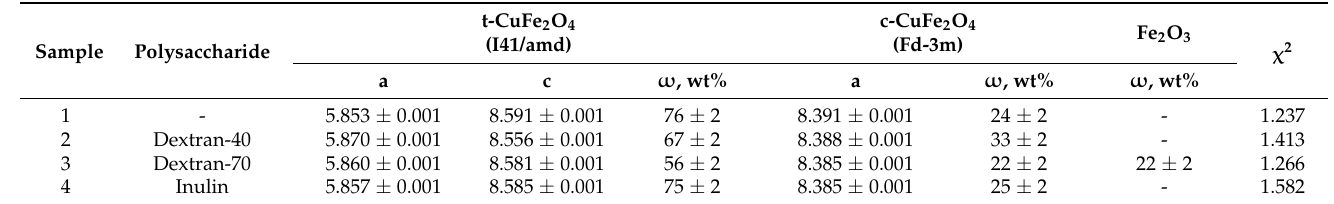
Table 2. Cell parameters and phase composition of the samples obtained by ion-exchange resin precipitation and annealed at 800 ◦ C for 1 h.